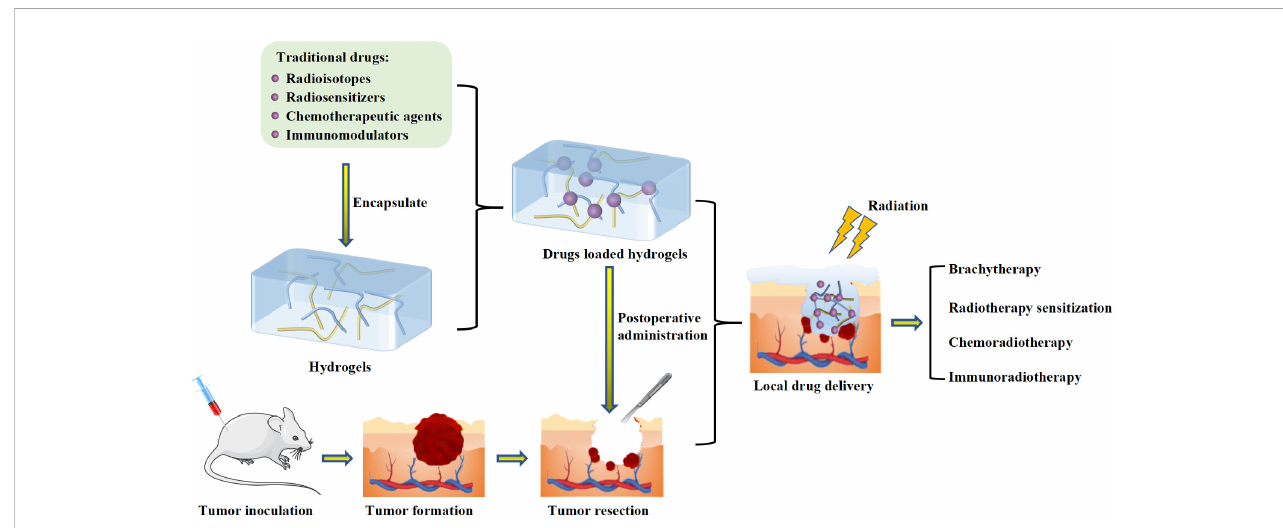
FIGURE 1 Schematic illumination of the application of hydrogel-based local drug delivery systems for postoperative